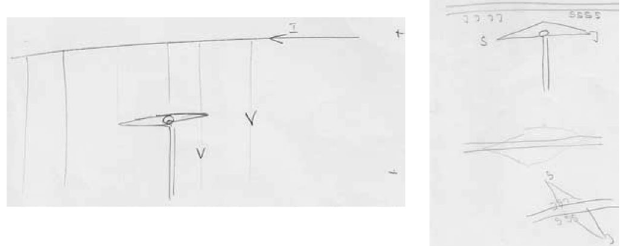
FIG. 7. Examples of students ’ graphical representations of magnetic field lines around current-carrying wire. Note that the abbreviations are J for south ( “ jug ” in Croatian) and S for north ( “ sjever ” in Croatian).